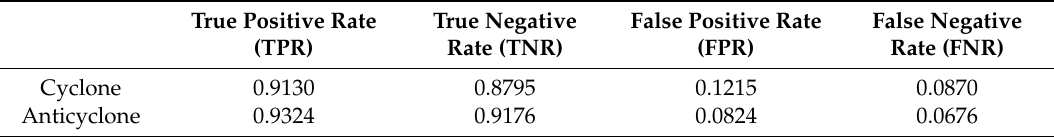
Figure 4. Confusion matrix of the test results. Table 1. Performance measurements for cyclones and anticyclones detection results.